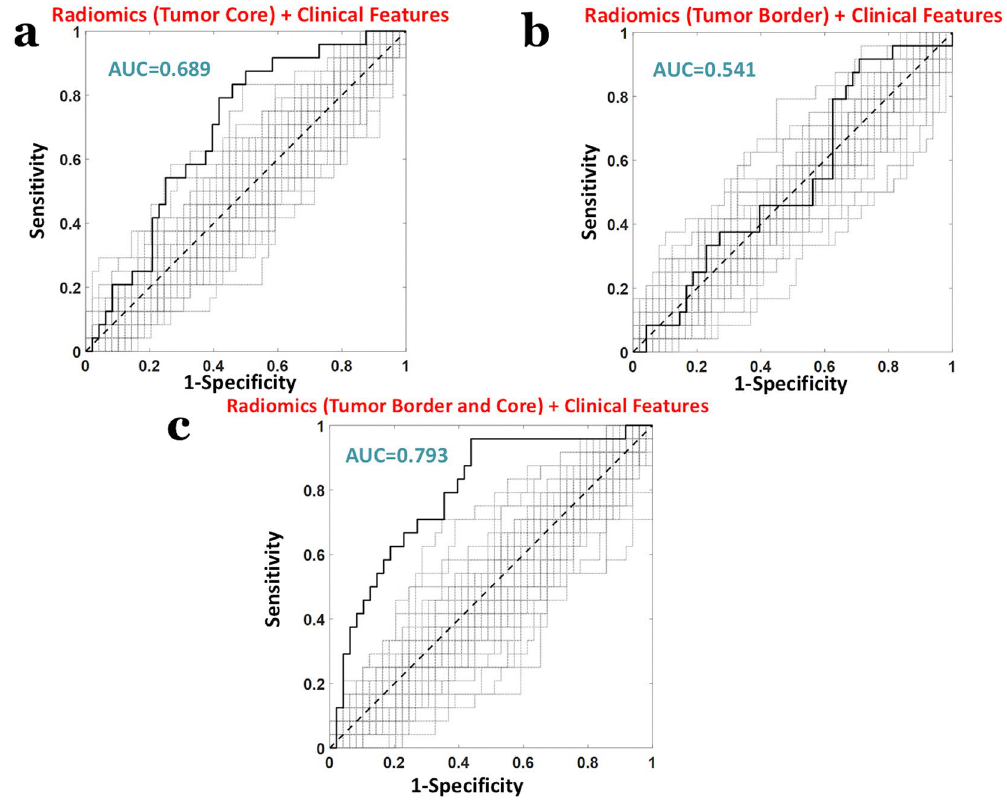
Figure 6. ROC analyses of the machine learning (PLS) classification performance predicting response to therapy (major pathological response labelled as “positive”, non-major pathological response labelled as “negative”) when considering ( a ) clinical and TC radiomic features ( b ) clinical and TB radiomic features and ( c ) clinical and TC + TB radiomic